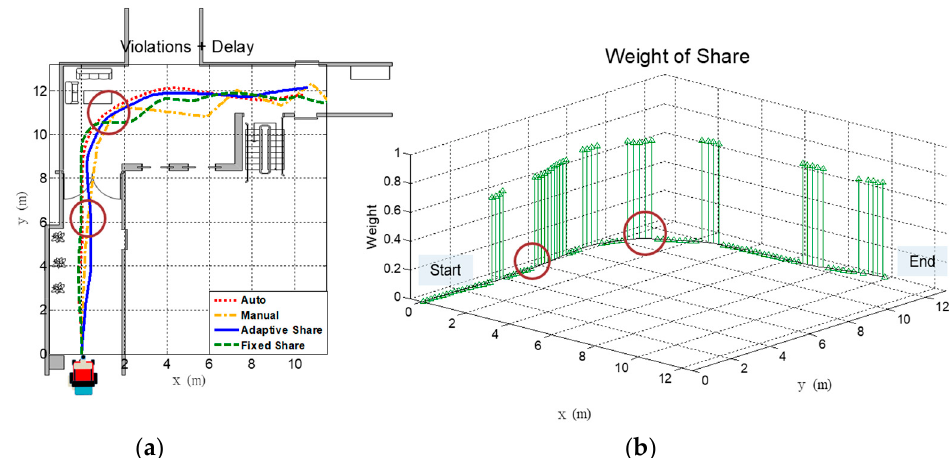
Figure 15. Experimental results of over-speeding operation plus with the skill-based error. ( a ) The trajectories of the four control modes. ( b ) Changes in the weights of adaptive shared control.